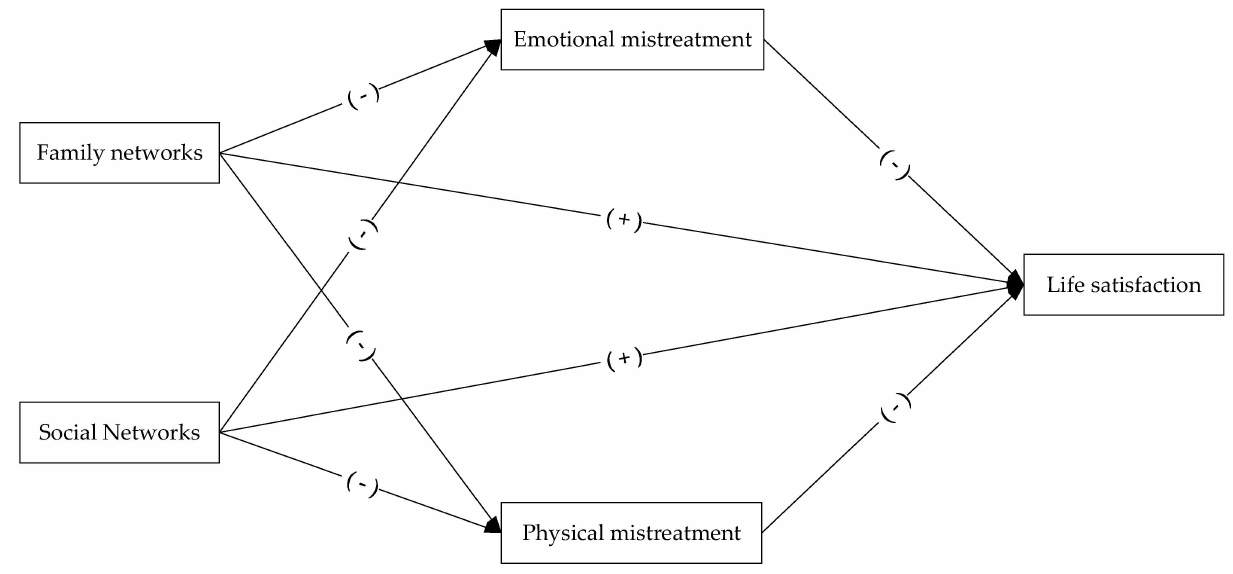
Figure 1. Conceptual